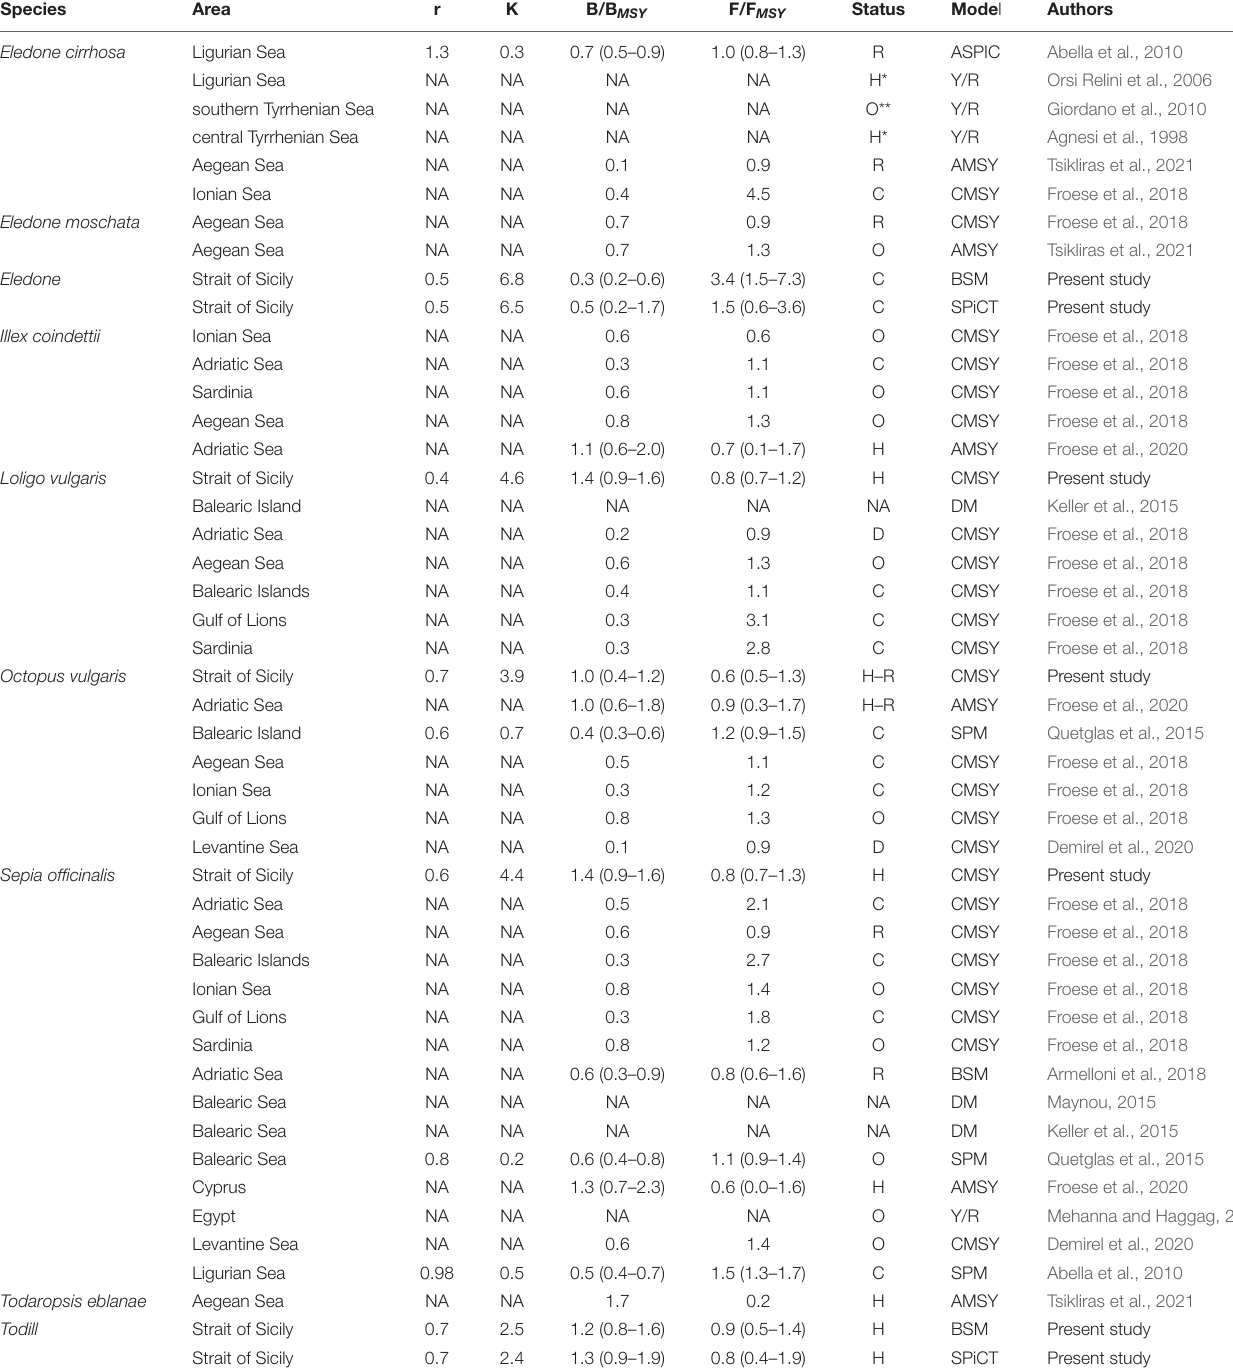
TABLE 4 | Synopsis of the cephalopod assessments carried out in Mediterranean stocks.